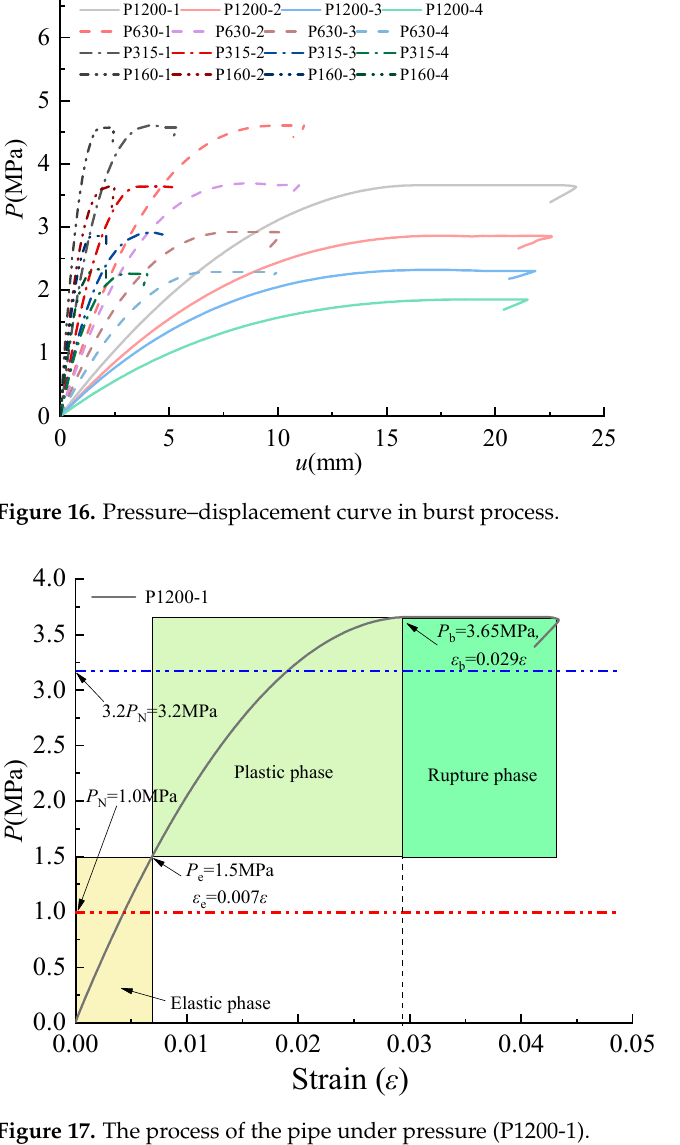
Figure 17. The process of the pipe under pressure (P1200-1).